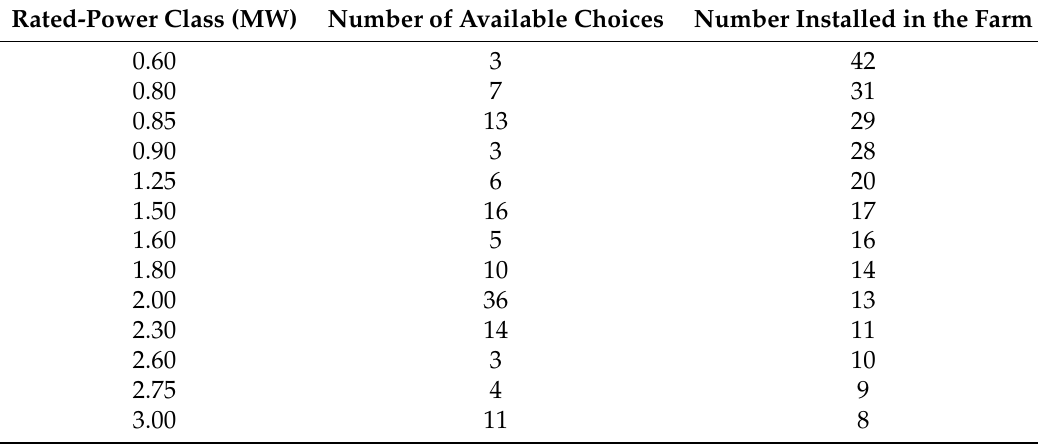
Table 2. Major commercial turbine choices in the U.S. onshore market.